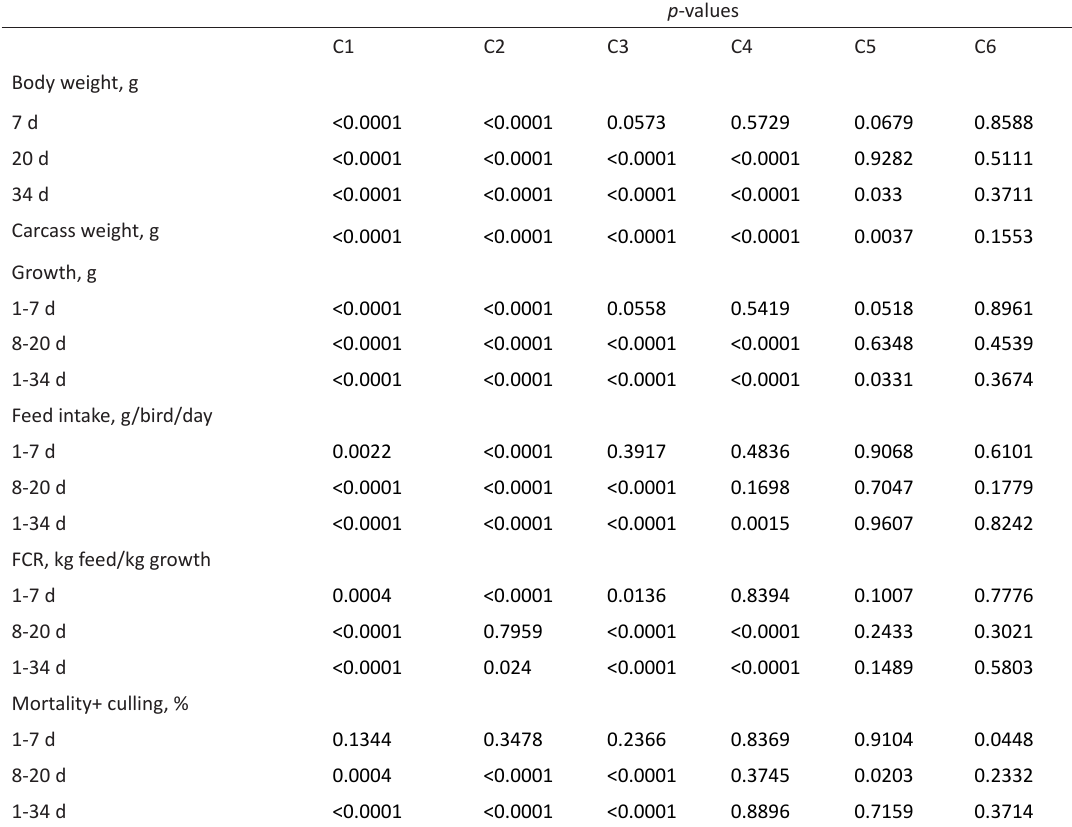
Table 5. Contrasts of the broiler chicken performance in response to treatment